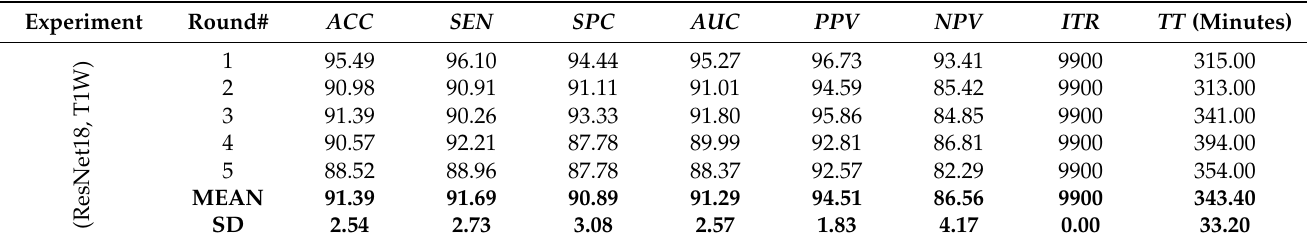
Table A4. Test results of five-folds of experiment (VGG16,